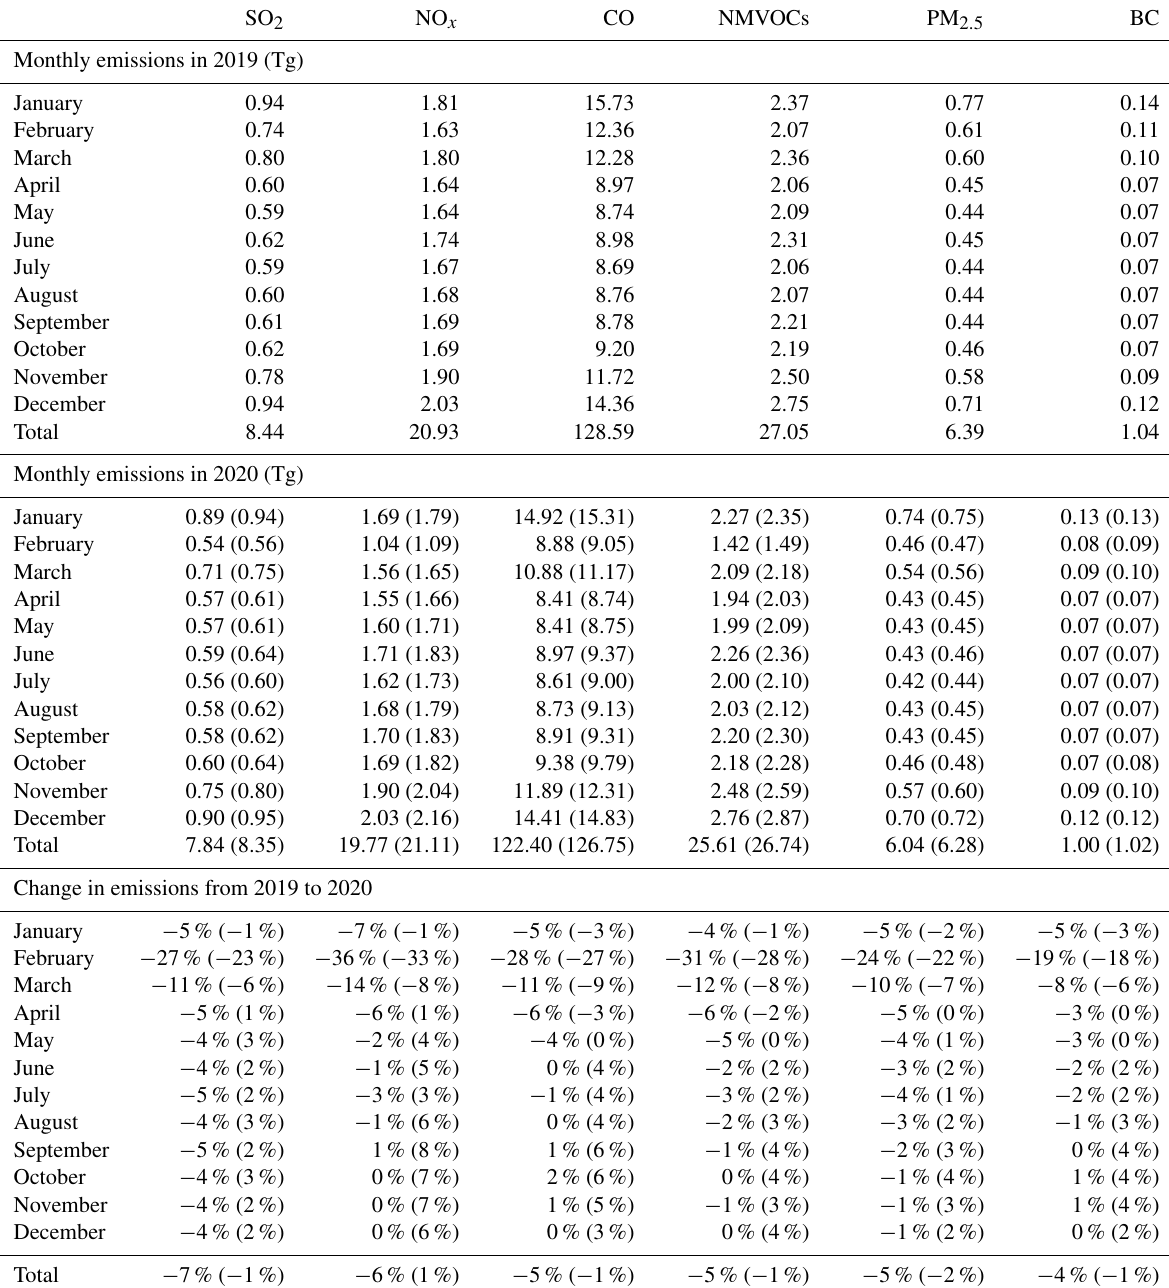
Table 1. China’s monthly anthropogenic emissions in 2019 and 2020. The values in brackets represent the emission estimation results in 2020 using the same emission factors as in